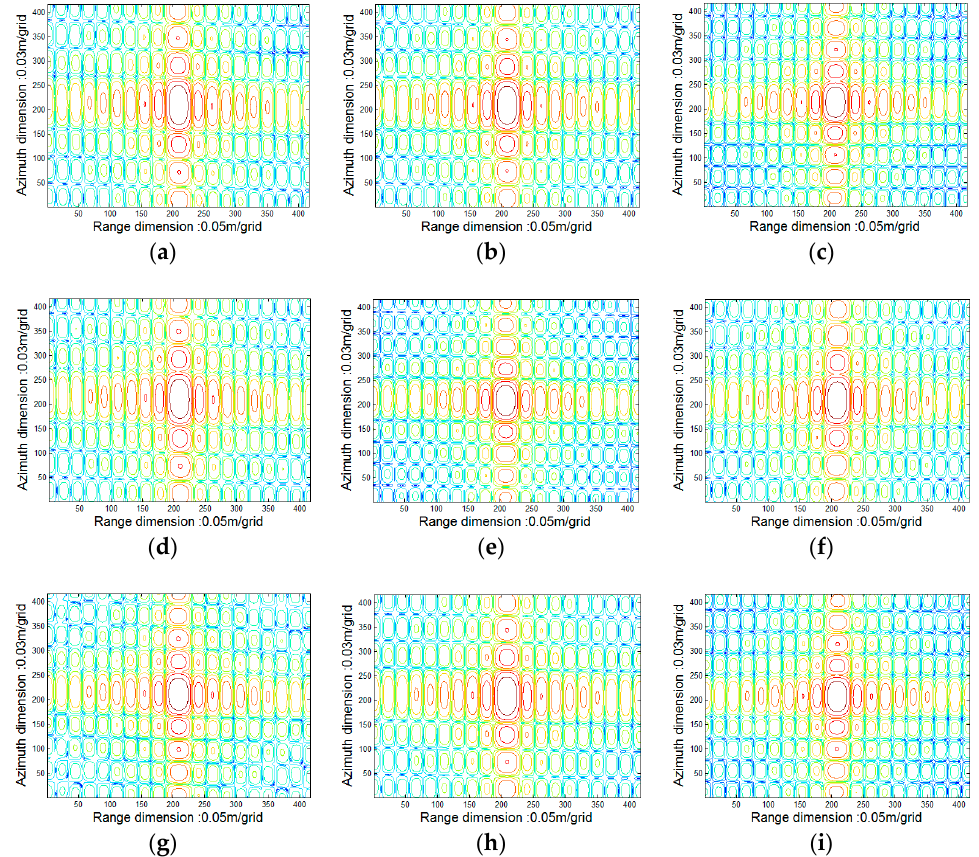
Figure 14. Contour plots focused: ( a ) T 11 ; ( b ) T 13 ; ( c ) T 15 ; ( d ) T 31 ; ( e ) T 33 ; ( f ) T 35 ; ( g ) T 51 ; ( h ) T 53 ; and ( i ) T 55 with the parameter adjusting technique. Table 5. Focusing quality evaluation.